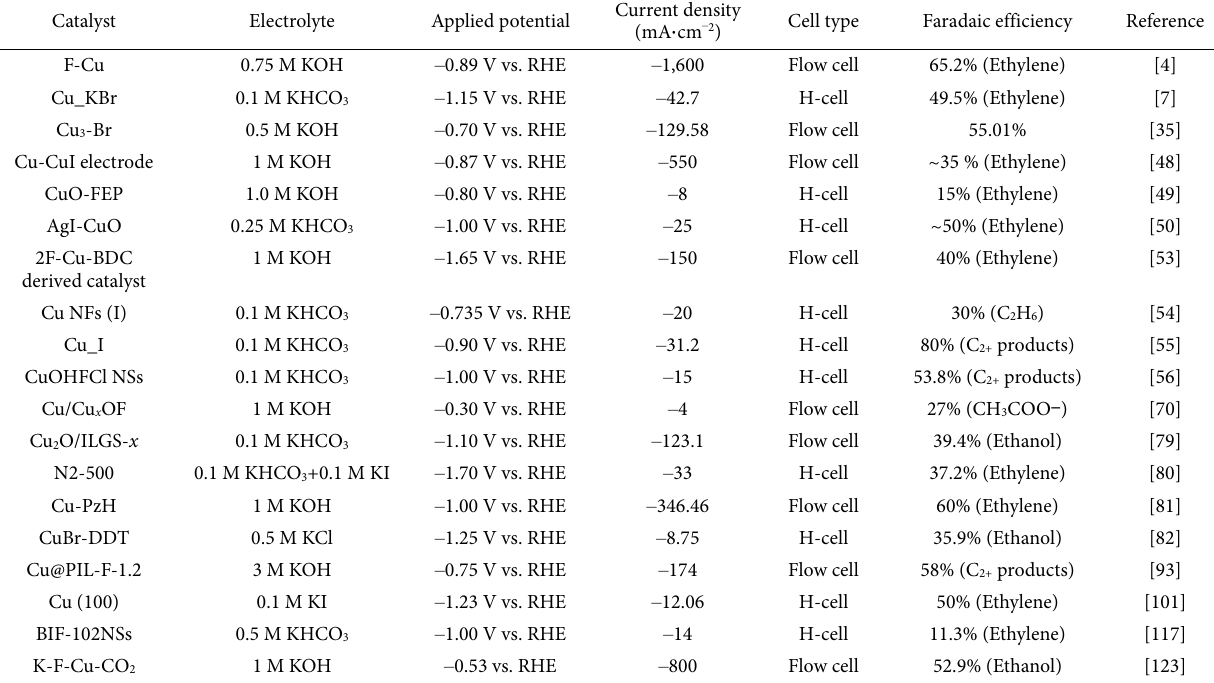
Table 1 Comparison of electrochemical performance of various copper-based catalysts for C 2+ products Catalyst Electrolyte Applied potential